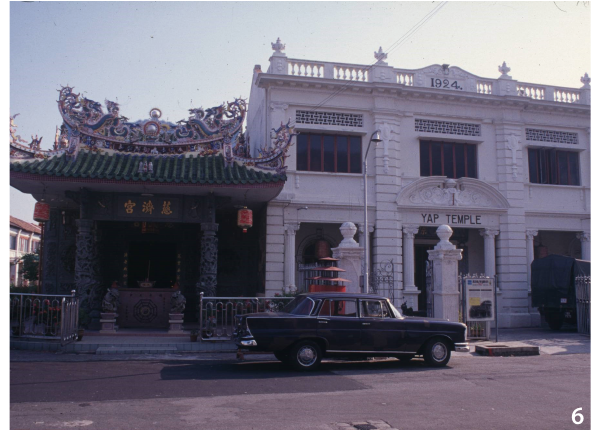
Figure 6 Community temple and Yap clan temple in Penang (Source: the